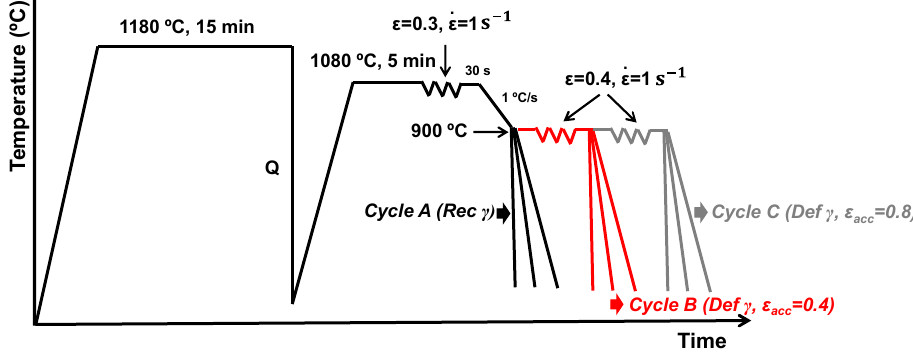
Figure 1. Thermomechanical cycle performed to determine the CCT diagram.